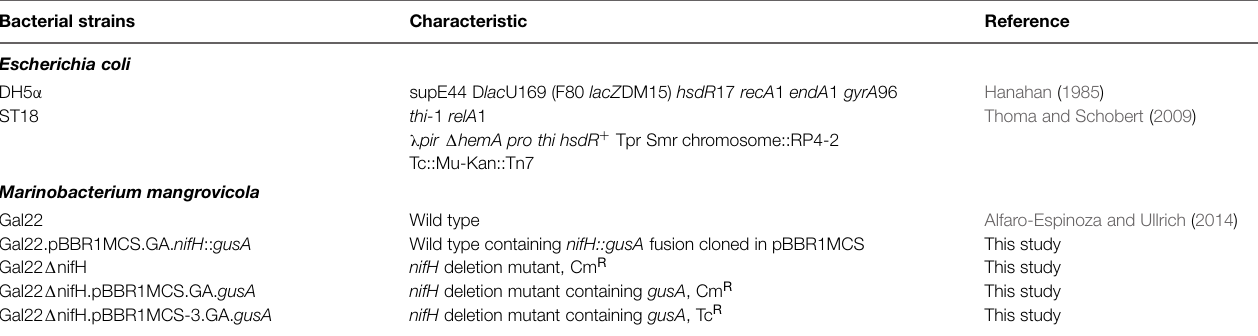
TABLE 1 | Bacterial strains used. Bacterial strains